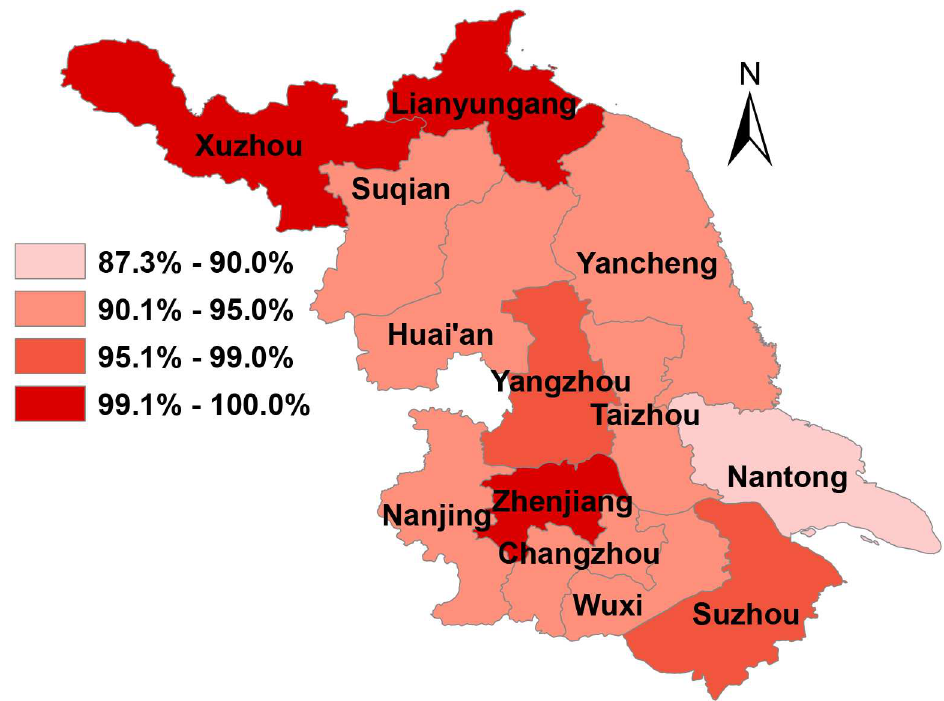
Fig 2. The proportion of first-detected patients at HIV clinics and first-methadone users at methadone clinics who receivedfree testing for syphilis in 2015. Zhenjiang, Lianyungangand Xuzhou had the highestproportion( > 99%), whileNantonghad the lowest